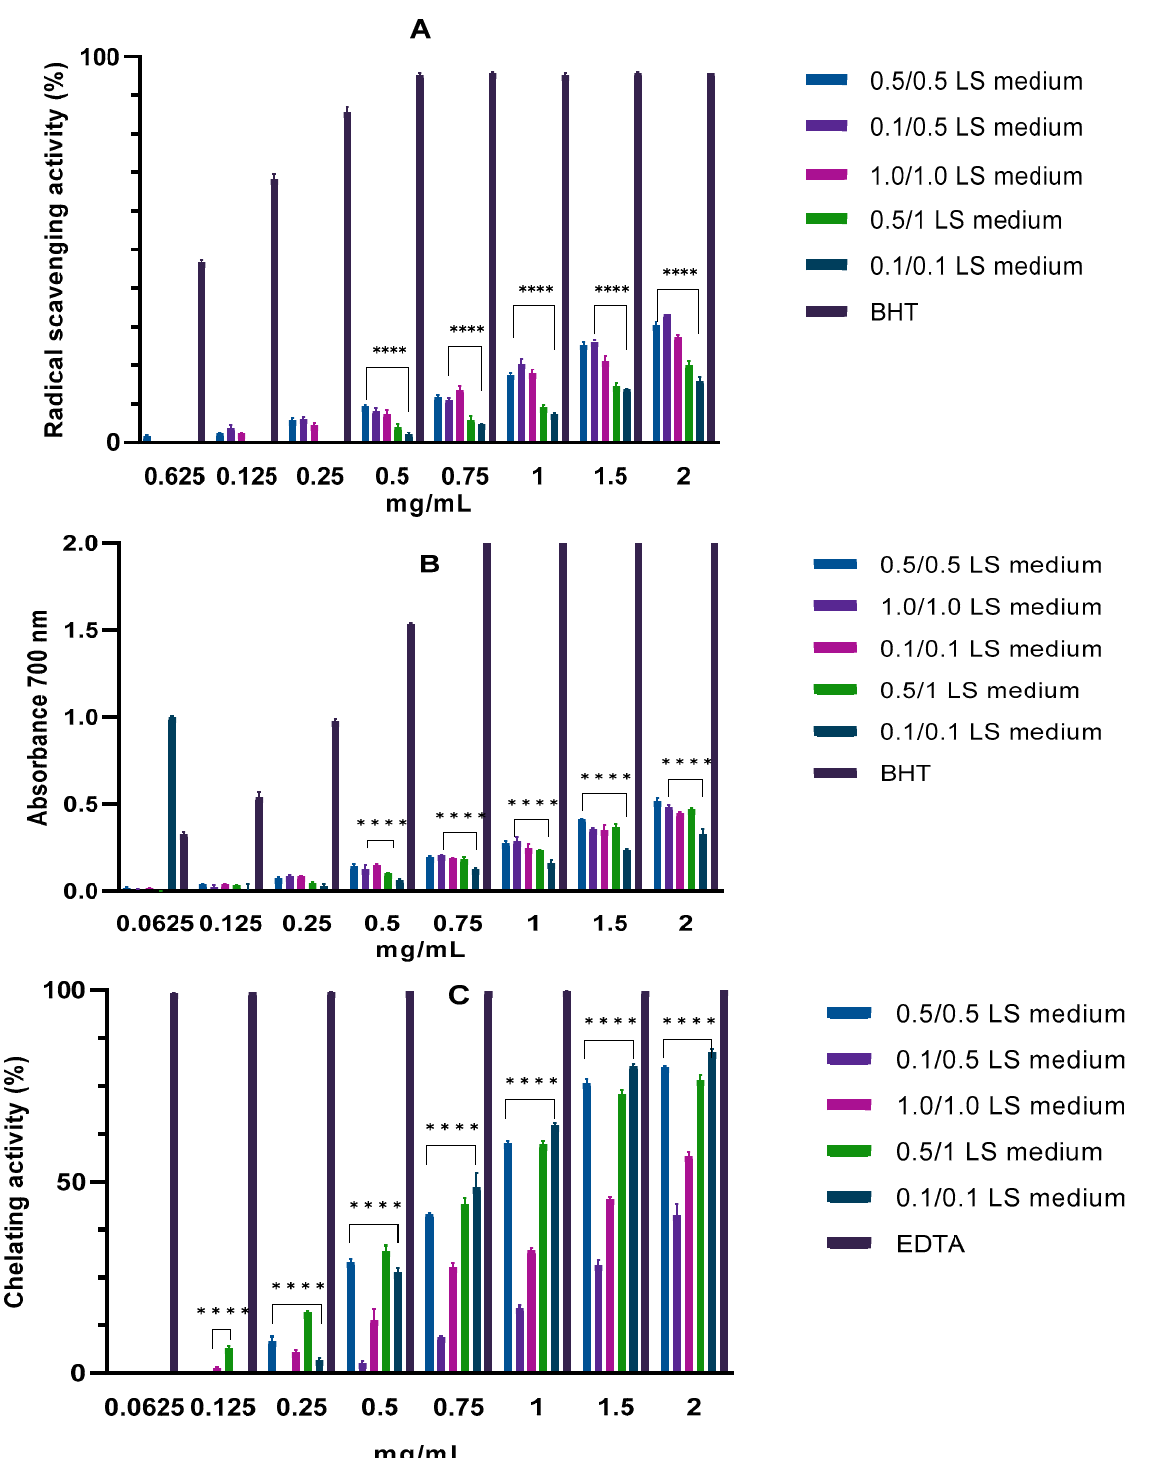
Figure 2. Free radical scavenging activity (DPPH assay) ( A ), reducing power ( B ), and ferrous ion chelating activity ( C ) of methanol extracts obtained from biomass of R. montana bioreactor cultures grown on LS medium variant supplemented with different concentrations of NAA/BAP mg/L (0.5/0.5, 0.1/0.5, 1.0/1.0, 0.1/0.1), after 5-week growth cycle. Reference standard: BHT ( A , B ), EDTA ( C ). Values are expressed as the mean ± SD ( n = 3). Statistically significant differences between di ff erent variant are indicated as **** p < 0.0001.